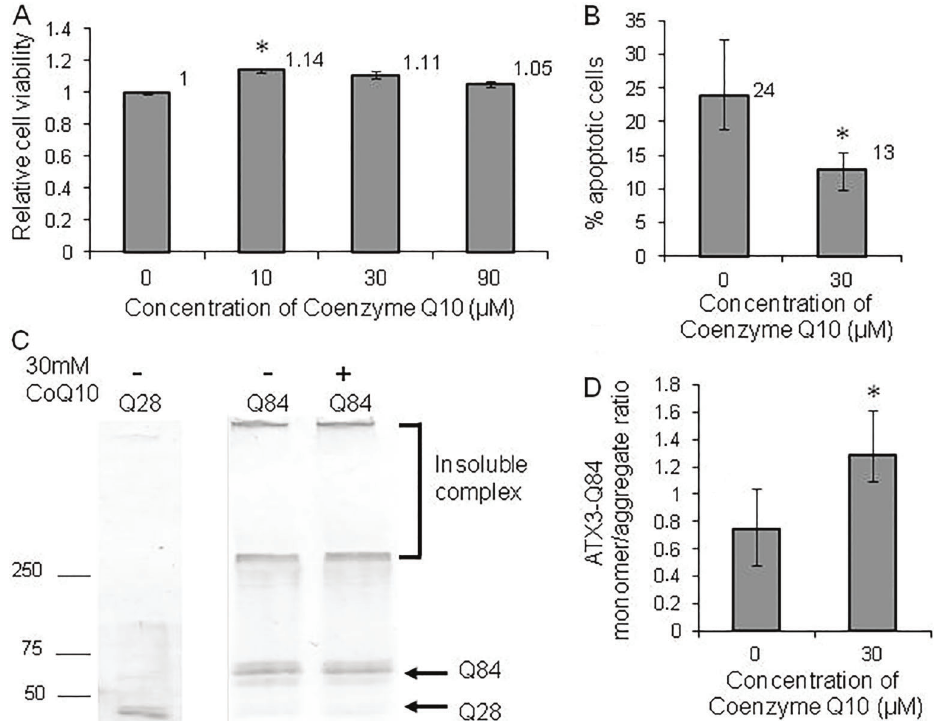
Figure 3. PC12 cells transfected with full-length expanded ATX3 (Q84), treated with different concentrations of coenzyme Q10 (CoQ10) and analyzed after 48 h. A , Relative cell viability was measured by the MTT assay. B , Percentage of apoptotic cells analyzed by fl ow cytometry after Annexin V and propidium iodide staining. C , ATX3-Q84 monomer/aggregate ratio analyzed by western blotting. D , Band densitometry was calculated with ImageJ software and the data of monomer/aggregate ratio were plotted in a graph. All experiments were performed in triplicate and data are reported as means ± SE. *P o 0.05, Kruskal-Wallis